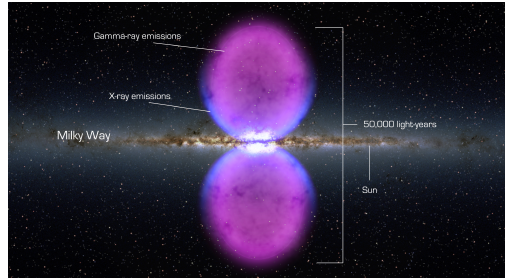
Figure 1: Most impressive evidence against a BH at our Galactic center: The FERMI Bubbles (or plumes), at photon energies (cid:46) 10 2 GeV, probably emitted by buoyantly rising relativistic pair plasma from the near vicinity of Sgr A*, throughout the Milky-Way halo, to heights well above 20 kpc, taken from [Su et al 2010, 2011]. These same halo structures had already been detected and mapped decades earlier by [Sofue 2000], from radio and X-ray